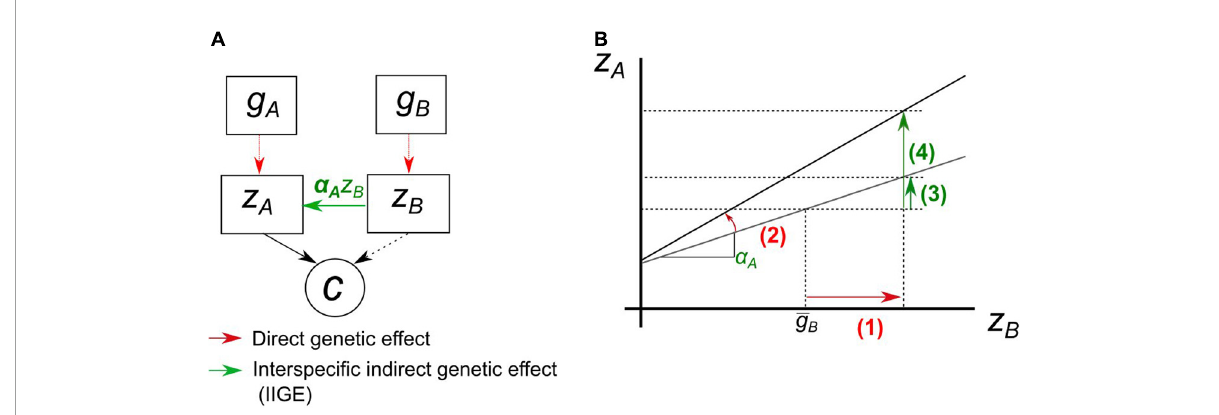
FIGURE4 Schematic representation of the reaction norm approach for a focal species A with an agronomic trait, z A , regressed on the interaction trait of a second species B , z B . (A) Each species is influenced by its own genotype. z A deviates under the influence of z B times its sensitivity to this trait α A , i.e., slope of the reaction norm to z B effect. The slope α A is itself a trait of species A , can be genetically variable and respond to selection. Both traits can potentially contribute to a community variable c . (B) Graphical representation of the path diagram. Selection on z B (1) involves a change in z A (3) through IIGE at α A constant. With the same amount of change in the interaction trait zB , if selection now also targets the genetic value of the slope (2), the magnitude of the IIGE is modified, here increased